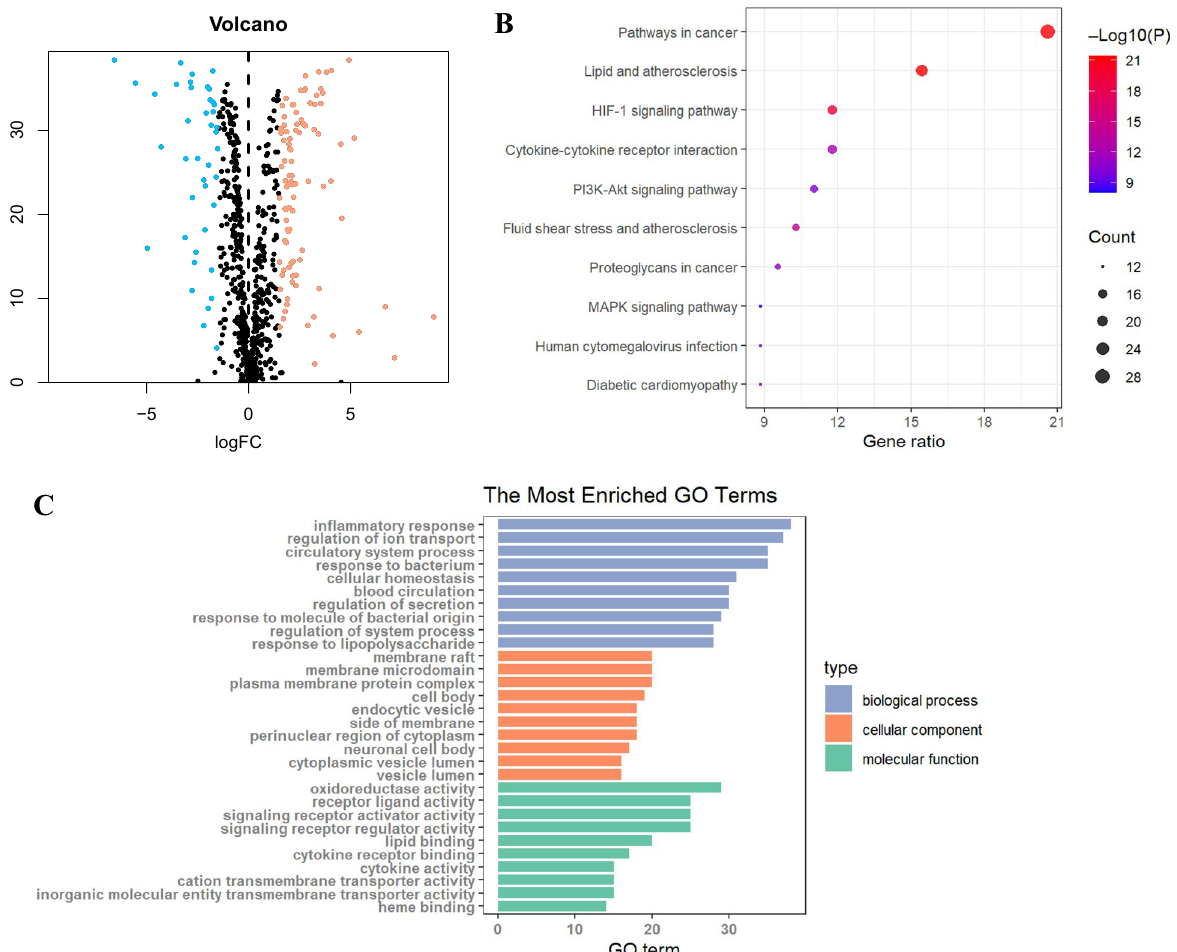
Figure 1. GO and KEGG analyses of OS-related DEGs in cancer and adjacent tissues. ( A ) Volcano plot of 137 OS-related genes in ccRCC. Red and blue dots represent up-regulated and down-regulated genes, respectively. ( B ) KEGG analysis of OS-related DEGs. ( C ) GO analysis of OS-related DEGs. GO, Gene Ontology; KEGG, Kyoto Encyclopaedia of Genes and Genomes; DEGs, differentially expressed genes; FC, fold change; FDR, false discovery rate; BP, biological process; CC, cellular components; MF, molecular